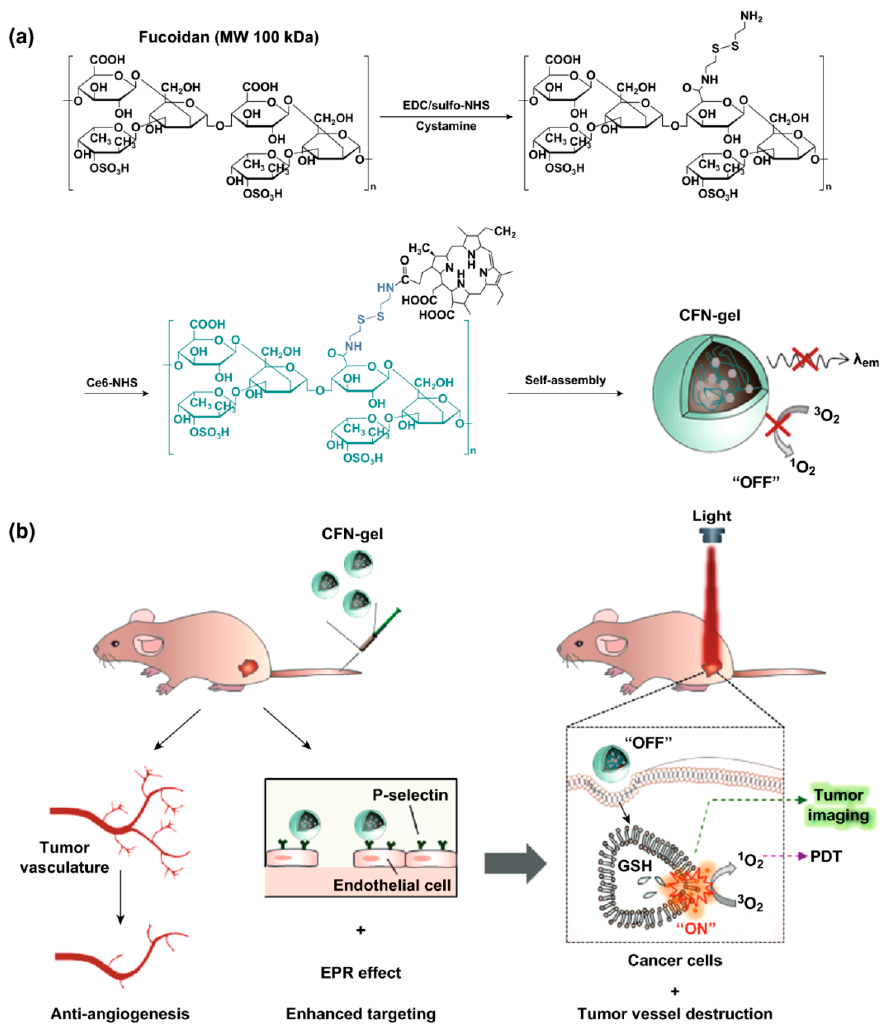
Figure 6. ( a ) Synthetic steps of Ce6–fucoidan theranostic nanogel (CFN-gel), ( b ) schematic illustration of CFN-gel and its mode of action. Reproduced from [305] with permission from Springer Nature,